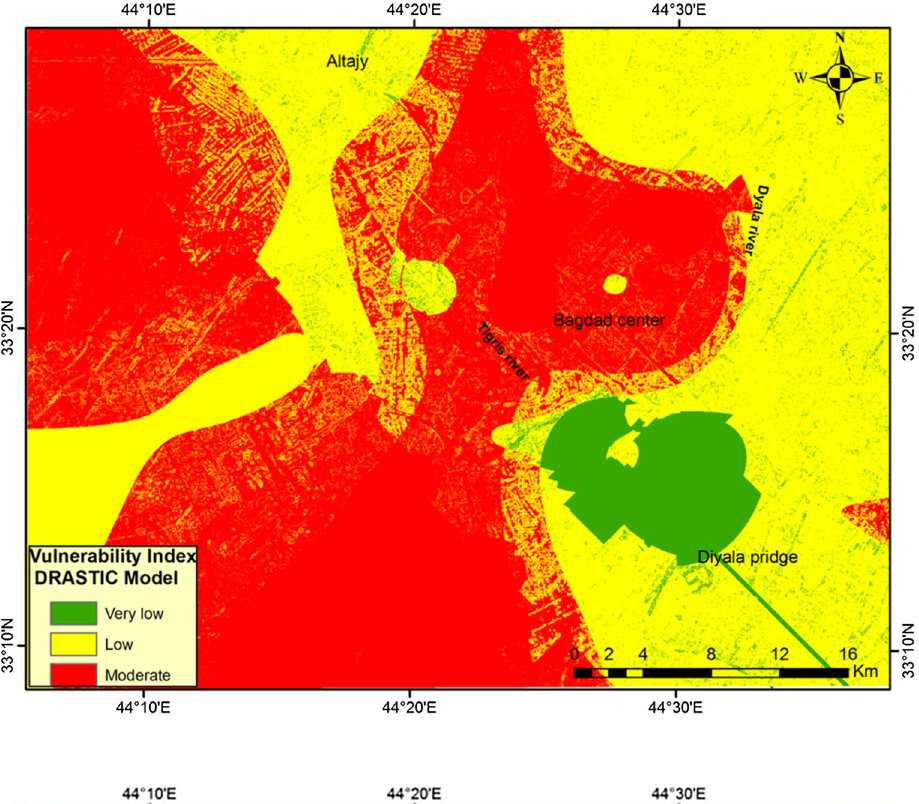
Fig. 14 Vulnerability index map (pesticide DRASTIC model) of the study